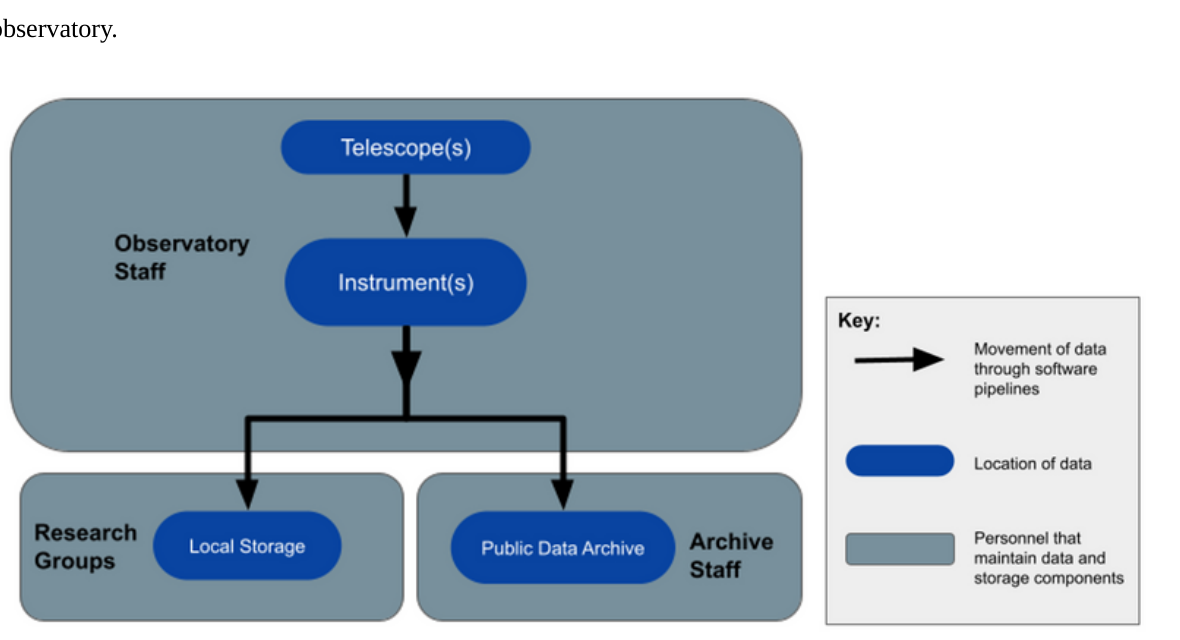
Figure 1. Overview of an astronomy data processing